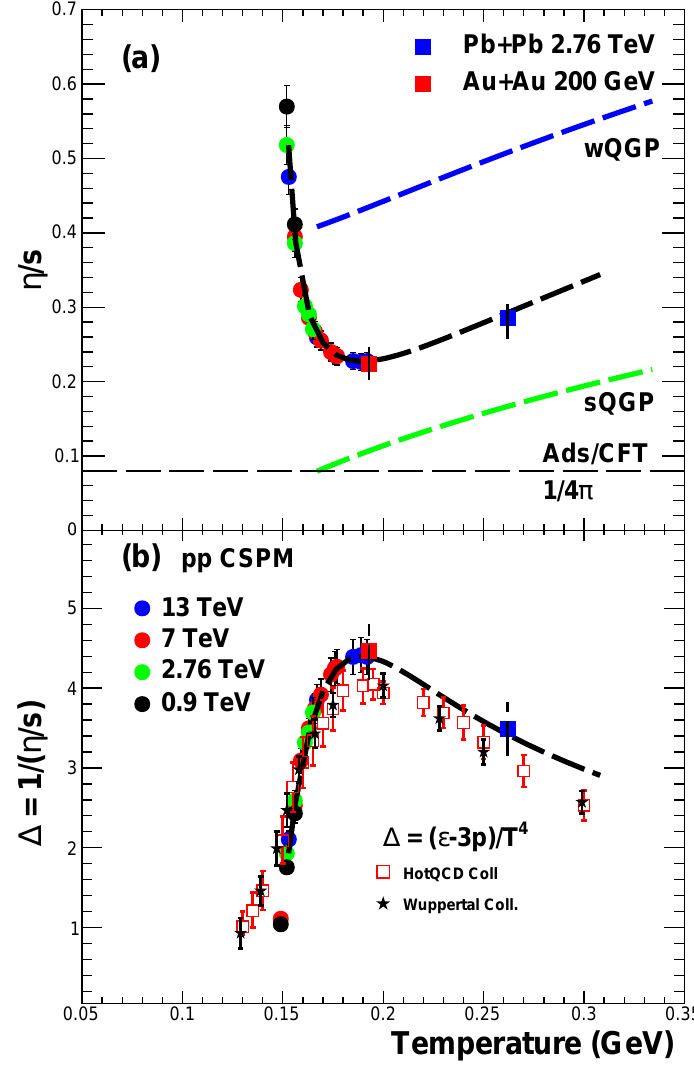
√ s = 0.9, 2.76, 7 and 13 TeV. Figure 10. ( a ) η / s as a function of temperature T using Equation (25) for The lower bound shown is given by the AdS/CFT [45]. For comparison purposes the results from √ s NN = 200 GeV and 2.76 TeV respectively are also shown as solid squares for Au-Au and Pb-Pb at 0–5 % centrality [19]. η / s estimates for wQGP and sQGP are shown as dotted blue and green lines respectively [43]. ( b ) The trace anomaly ∆ = ( ε − 3 p ) / T 4 vs. temperature. Blue open squares are from HotQCD Collaboration [46]. Black stars are from Wuppertal Collaboration [47]. The CSPM results are obtained as ∆ = 1/ ( η / s ) [19]. The black dashed line both in ( a , b ) corresponds to extrapolation from CSPM at higher